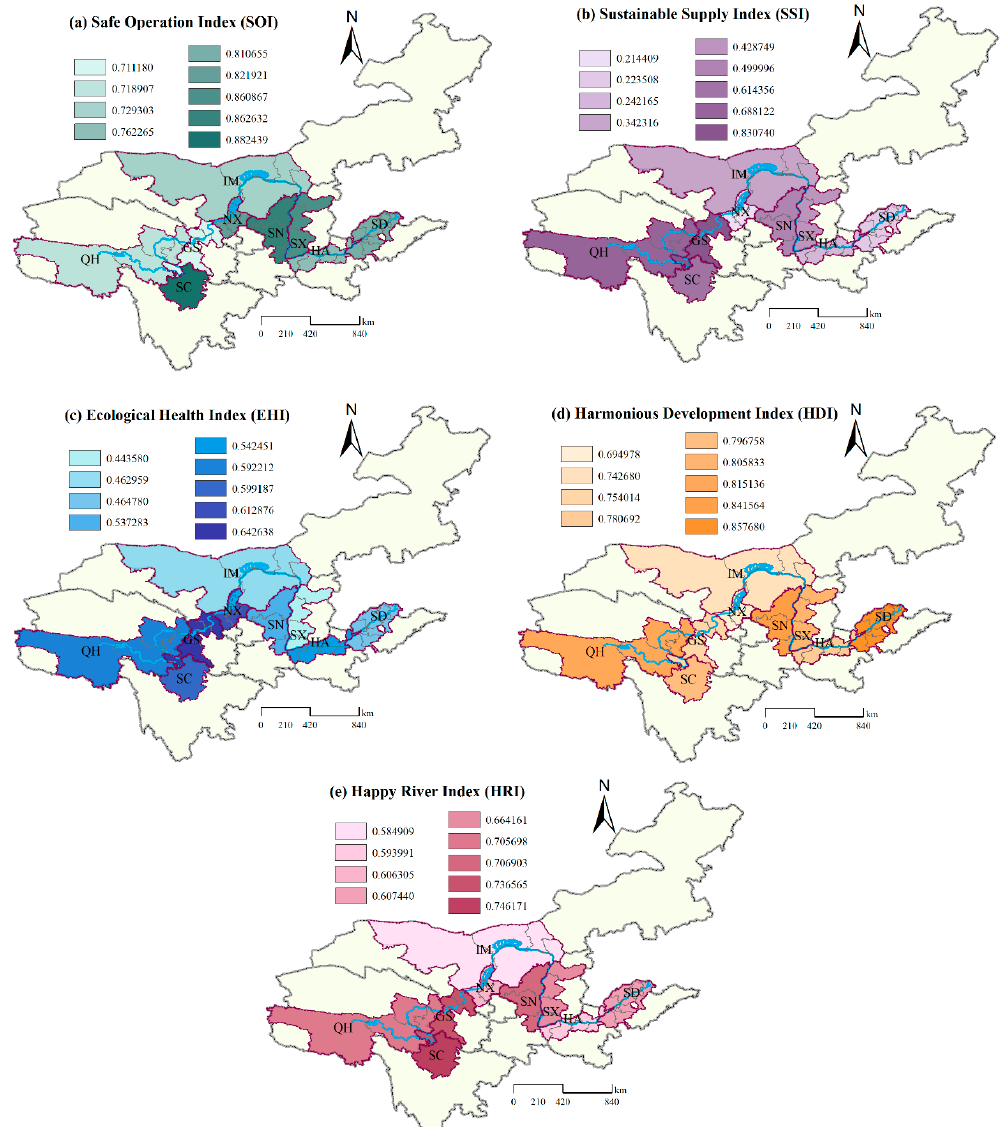
Figure 7. Maps showing the spatial distributions of ( a ) the safe operation index; ( b ) sustainable water supply index; ( c ) ecological health index; ( d ) harmonious development index; and ( e ) happy river index. Here, the labels “QH”, “SC”, “GS”, “NX”, “IM”, “SN”, “SX”, “HA”, and “SD” refer to the provinces and regions of Qinghai, Sichuan, Gansu, Ningxia, Inner Mongolia, Shaanxi, Shanxi, Henan, and Shandong, respectively.